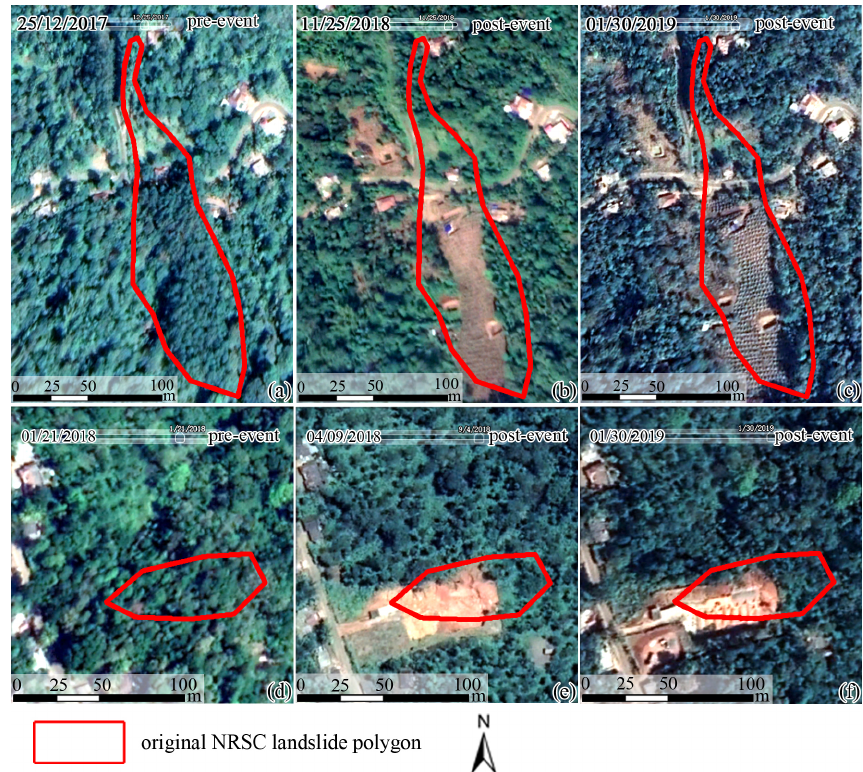
Figure 4. Examples of landslides in the NRSC inventory that were not considered as actual landslides after visual inspection. The example in (a) – (c) shows that the changes in the polygon before and after the event were caused by vegetation clearing and agricultural activities. Images (d) – (f) show that the changes near the polygon before and after the event were caused by building construction. Basemap data © Google Earth 2019.